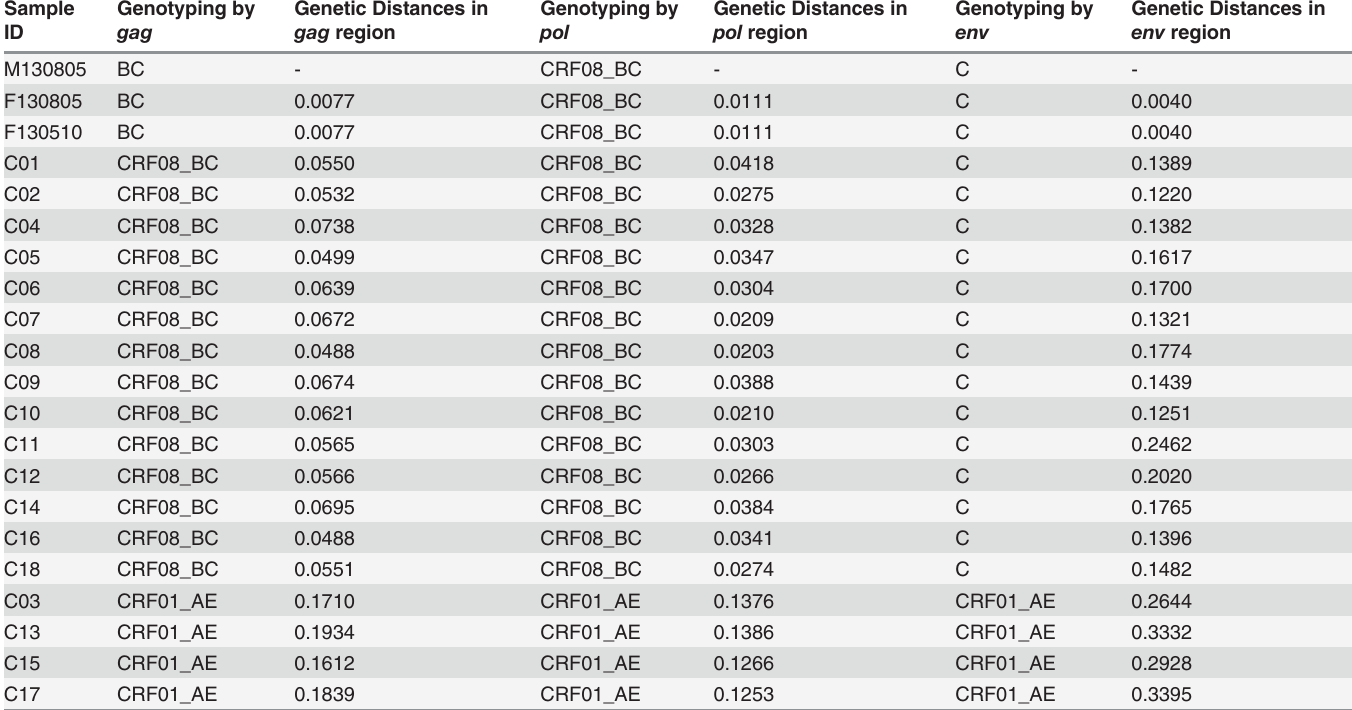
Table 2. The genetic distances to M130805 within three genes